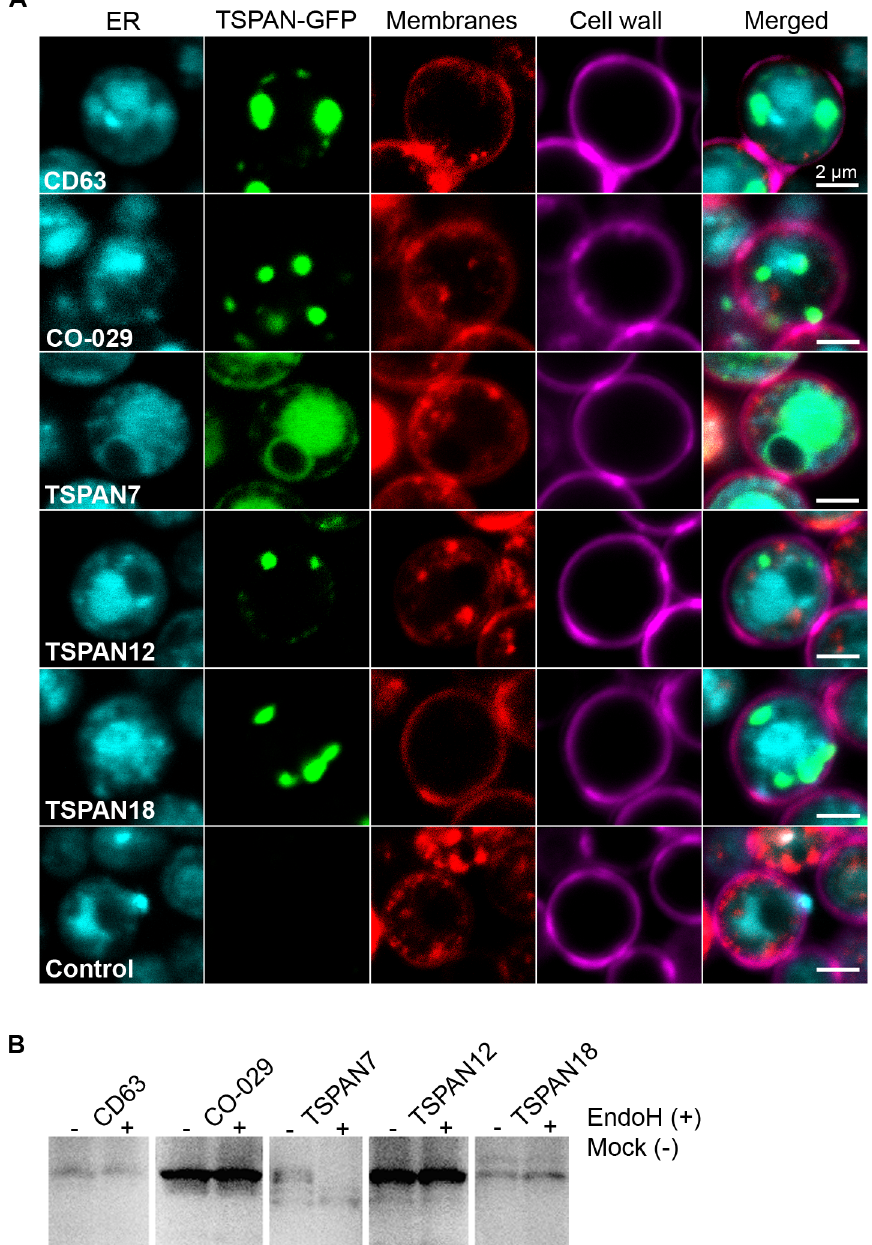
Fig 3. Cellular localization and posttranslational modification of recombinant human tetraspanins. (A) Representative confocal images of S . cerevisiae cells expressing human tetraspanin proteins with a C- terminal GFP tag. ER membranes were visualized by ER-tracker Blue-White DPX (cyan), tetraspanin-GFP fusion proteins were visualized by a native GFP fluorescence (green), membranes were visualized by FM 4- 64FX (red) and cell wall was visualized by Concanavalin A Alexa Fluor 647 Conjugate (magenta). Each channel is shown separately for clarity and then merged. Scale bar: 2 μ m (B) SDS-PAGE in-gel fluorescence of crude S . cerevisiae membranes containing GFP-tagged tetraspanins after EndoH treatment (+) and controls prepared in the same way but without EndoH (-). A shift of the fluorescent band to a lower molecular mass after EndoH treatment is observed only in case of